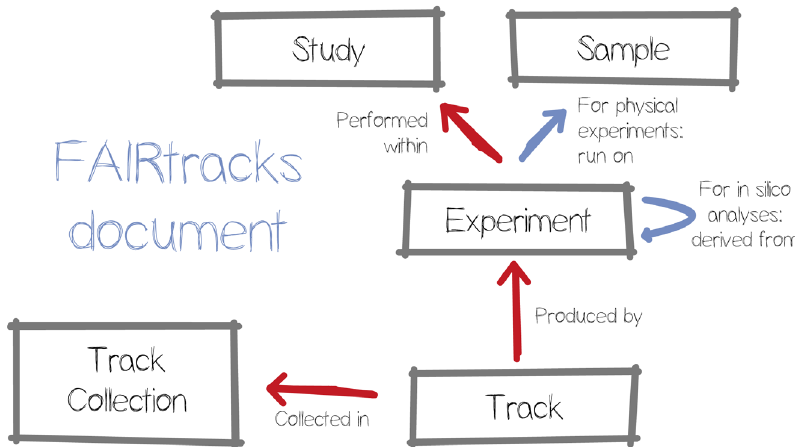
Figure 1. Overview of the key objects in the proposed data model, and the relationships between